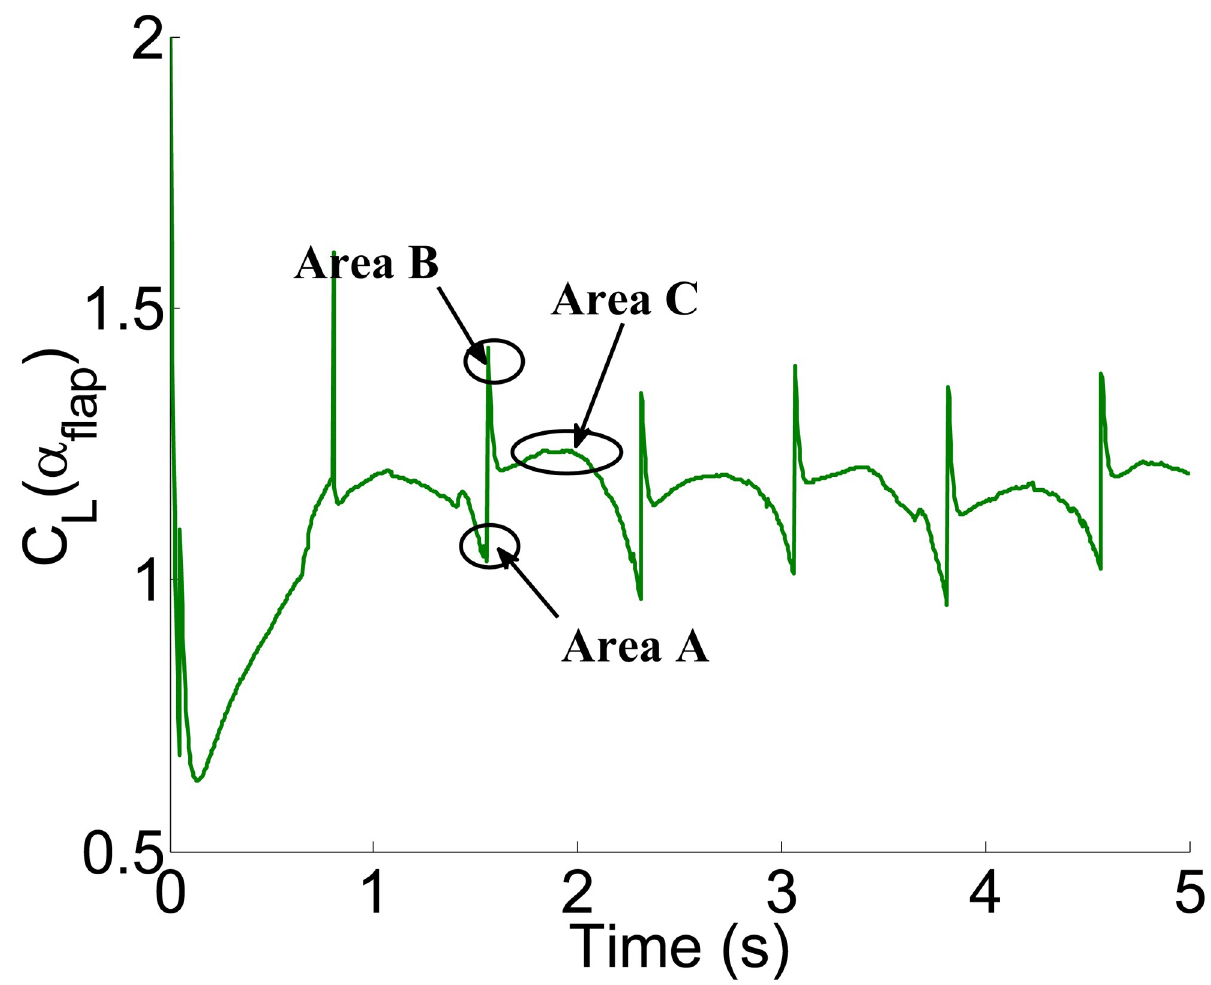
Fig 7. The dynamic lift coefficient curve of two